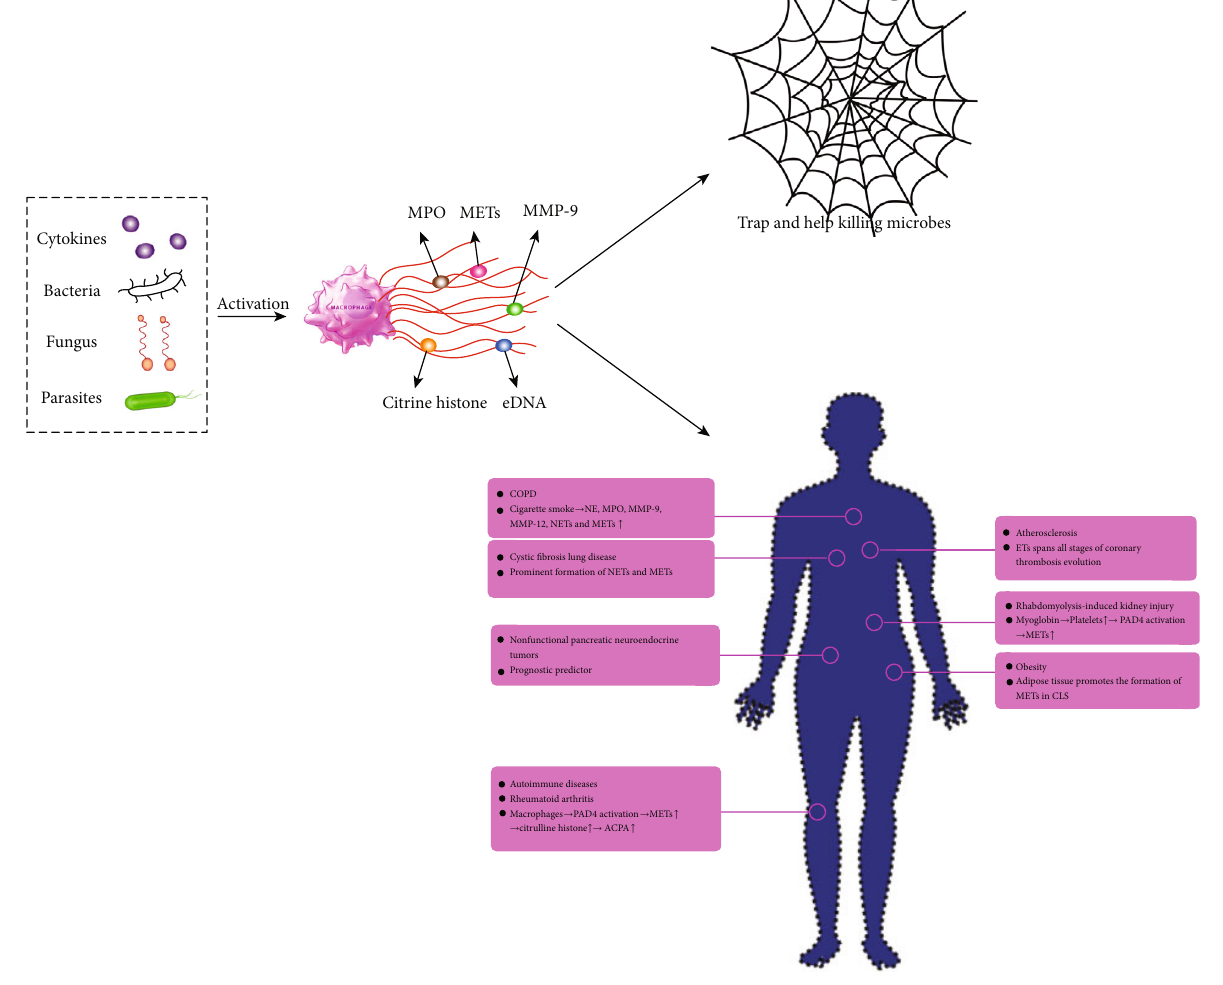
Figure 1: Macrophage extracellular traps (METs): induction, structure, and function. MPO: myeloperoxidase; MMP-9: matrix metalloproteinase-9; eDNA: extracellular DNA; COPD: chronic obstructive pulmonary disease; NE: neutrophil elastase; MMP-12: matrix metalloproteinase-12; NETs: neutrophil extracellular traps; PAD: peptidylarginine deiminase; ACPA: anti-citrullinated protein antibody; CLS: crown-like